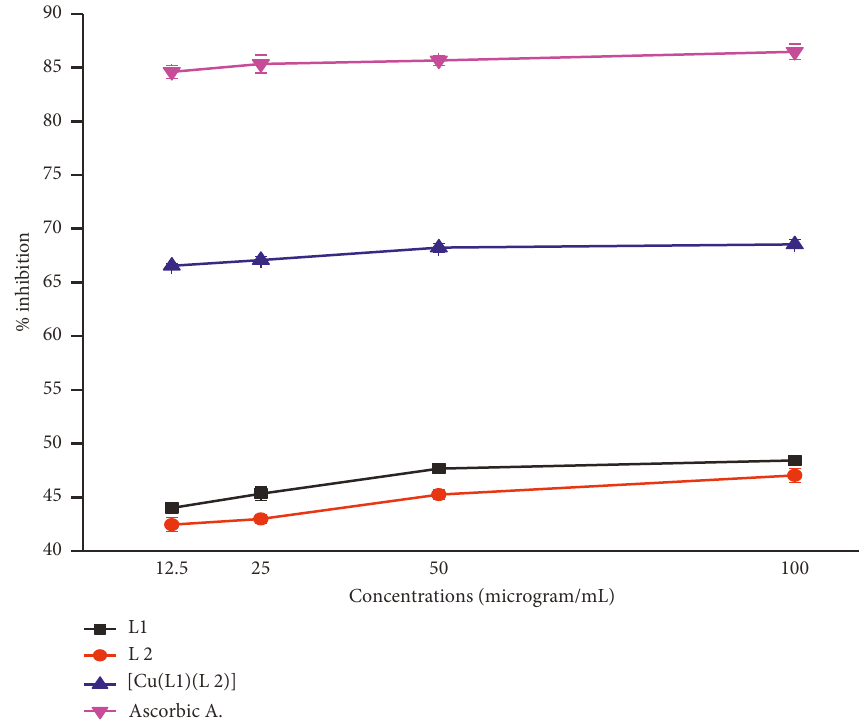
Figure 17: Antiradical potential (%) of samples relative to ascorbic acid.